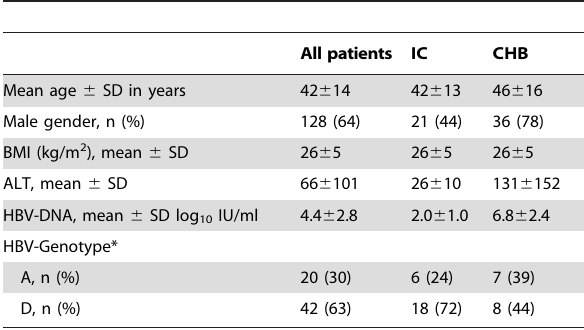
Table 2. Clinical characteristics of patients with persistent HBV infection (n=201).